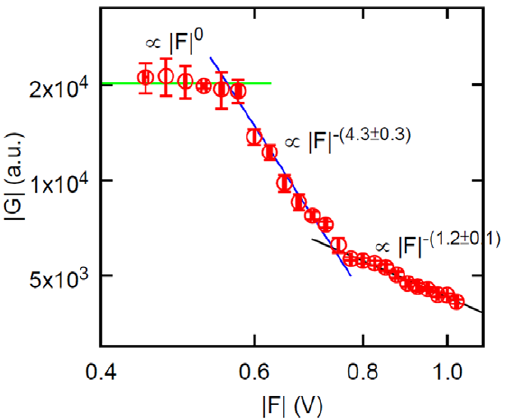
Figure 5. Complex modulus from the dynamic stretching experiments. Magnitude of the complex modulus of the protein as a function of the amplitude of the applied force. The error bars represent standard deviation of 5